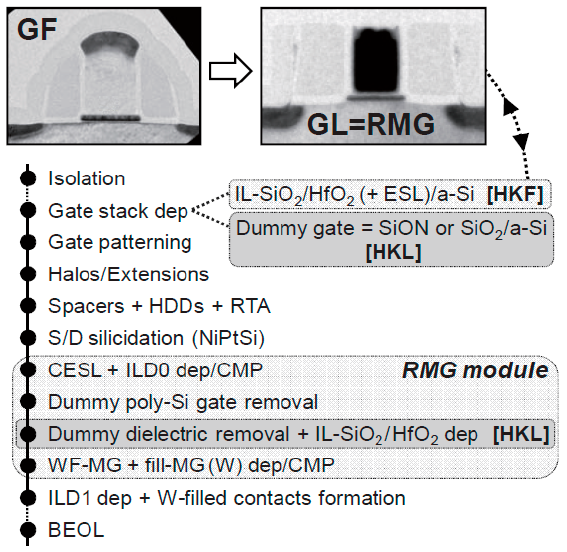
Figure 19. Planar transistors with high- k metal gate processes, including replacement metal gate (RMG) modules. (Reprinted with permission from [3]. Copyright Japan Society of Applied Physics, 2011).